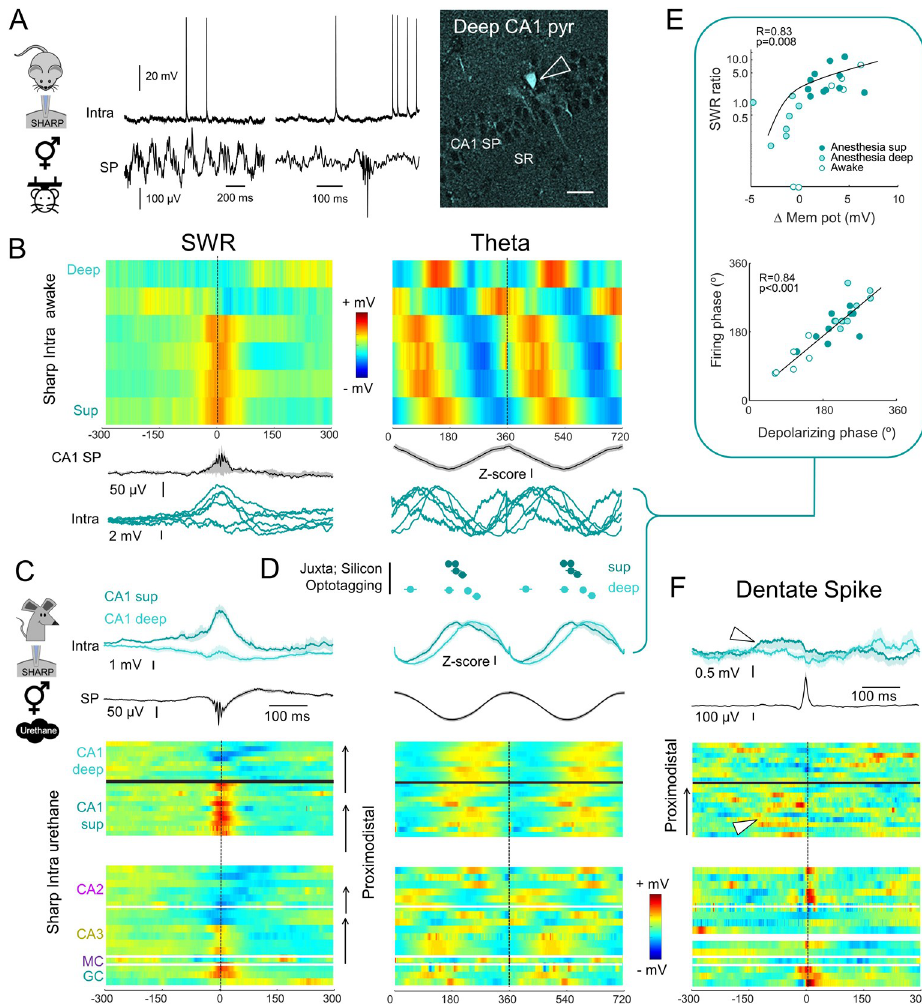
Fig 4. Comparison across recording conditions. (A) Intracellular and LFP recordings obtained from awake head- fixed mice. The example CA1 cell was classified as a deep pyramidal cell (right). ( B) Heatmaps of mean membrane potential responses from all CA1 pyramidal cells recorded in awake head-fixed mice ( n = 6), aligned by the SWR peak (left). The morphologically validated deep and superficial cells are plotted at both extremes. Remaining cells were ranked by the mean depolarizing response during SWR. Similar heatmaps for membrane potential fluctuations during theta are shown at right, with cells order as ranked by SWR. The mean LFP event is shown below in black, and SD is depicted in gray. Individual traces from cells are shown in blue. ( C) Same as before for CA1 pyramidal cells recorded intracellularly with sharp pipettes under anesthesia ( n = 11 superficial CA1 pyramidal cells, n = 8 deep CA1 pyramidal cells). Mean ± SEM of membrane potential responses from deep and superficial CA1 cells are shown at top for comparison with awake intracellular data. The rest of cells are shown below (urethane; n = 3 granule cells, n = 1 mossy cell; n = 7 CA3 pyramidal cells; n = 5 CA2 pyramidal cells), all ranked according to their proximodistal location within each region. Note consistent membrane potential gradients across CA3 and CA2. ( D) Theta phase-locked firing data of deep and superficial CA1 pyramidal cells obtained with juxtacellular electrode [7,28], silicon probe [38,39],and optotagging recordings [28] in awake mice and rats. Note consistent phase-locking across conditions and preparations for superficial cells but not for deep cells. ( E) Correlation between membrane potential responses and firing rate indices of CA1 pyramidal cells during SWR (top; exponential fitting) and theta (bottom), estimated with sharp intracellular recordings in anesthesia and awake conditions. ( F) Same as in panels B and C for DS recorded under urethane anesthesia in rats. Cells follow the same proximodistal order as in panel C. Note sharp depolarizing responses at the DS peak in granule cells and CA2 pyramidal cells, and the sustained plateau depolarization in superficial CA1 pyramidal cells (arrowhead). Note also hyperpolarizing responses in deep CA1 pyramidal cells. The underlying data can be found in S1 Data. DS, dentate spikes; LFP, local field potential; SD, standard deviation; SP, stratum pyramidale; SR, stratum radiatum; SWR, sharp-wave ripple.